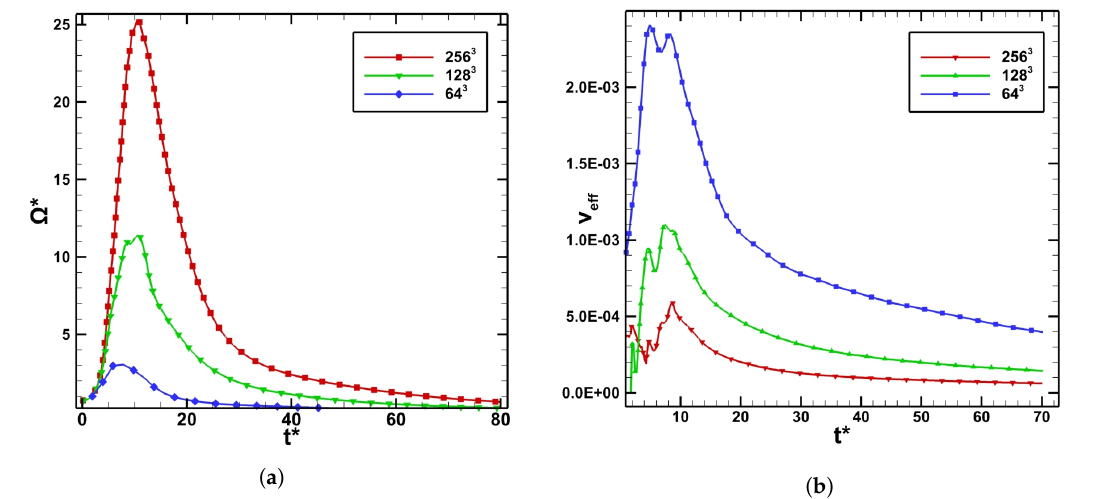
Figure 5. Variation of the volume-averaged enstrophy and the volume-averaged effective viscosity during the course of the simulations performed using DSMG-M3 on three different grid levels. ( a ) LES, enstrophy; ( b ) LES, effective viscosity.